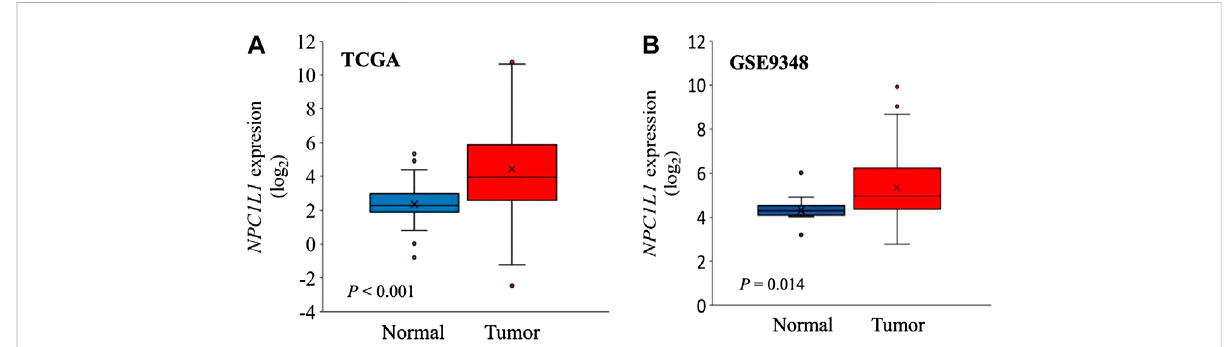
FIGURE 3 NPC1L1 expression in normal and CRC tissues. (A) NPC1L1 expression is higher in most CRC tissues than in normal tissues. The mean value of the NPC1L1 expression in normal tissues (blue box) is 7.00, and in CRC tissues (red box), it is 130.09. (B) Mean value of the NPC1L1 expression in normal tissues (blue box) is 22.69, and in CRC tissues (red box), it is 81.35 compared to normal tissues (GSE9348) (Kwon et al., 2021).